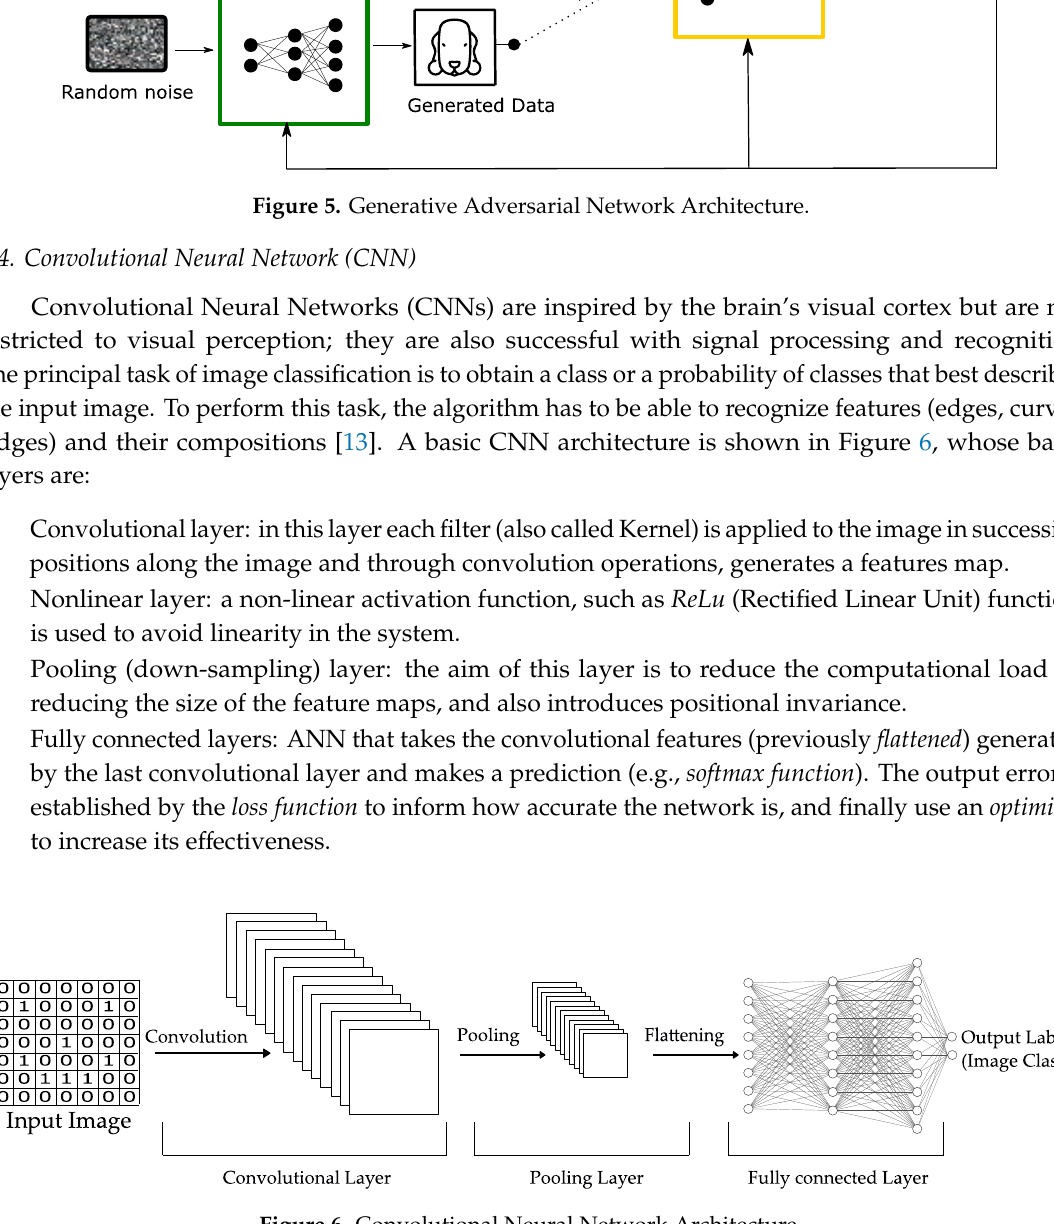
Figure 6. Convolutional Neural Network Architecture.